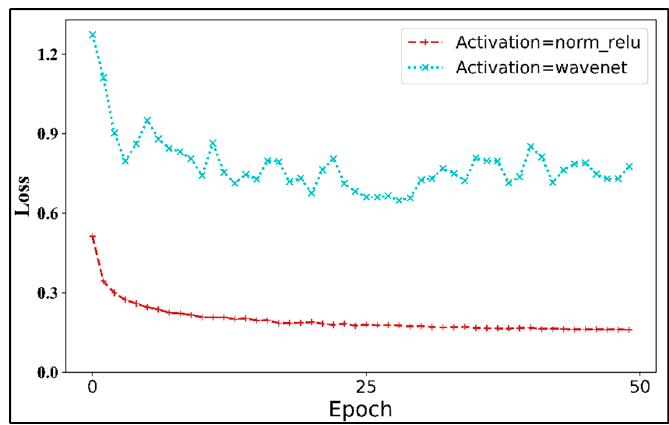
Figure 5. Convergence error of cost function for two nonlinear activation functions.